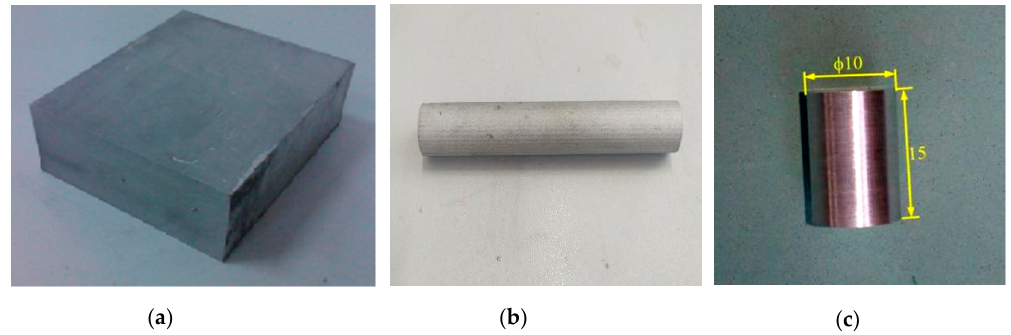
Figure 2. Sampling location.